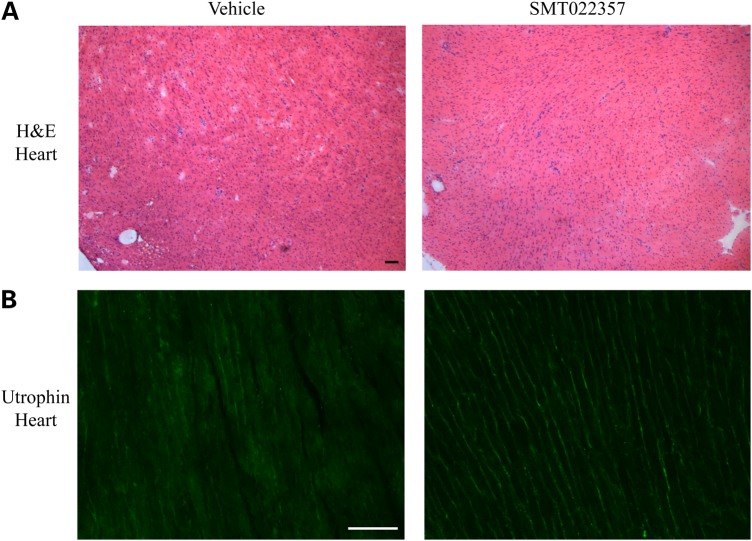
SMT022357 increases utrophin expression in the mdx heart. (A) H&E staining of transverse heart sections in 7-week-old, vehicle- and SMT022357-treated mdx mice. n = 10 per group. Scale bar: 100 µm. (B) Immunostaining showed an increase of utrophin in the heart of 7-week-old mdx mice after SMT022357 (30 mg/kg/day) treatment compared to the vehicle group. (n = 10 per group); Scale bar: 100 µm.